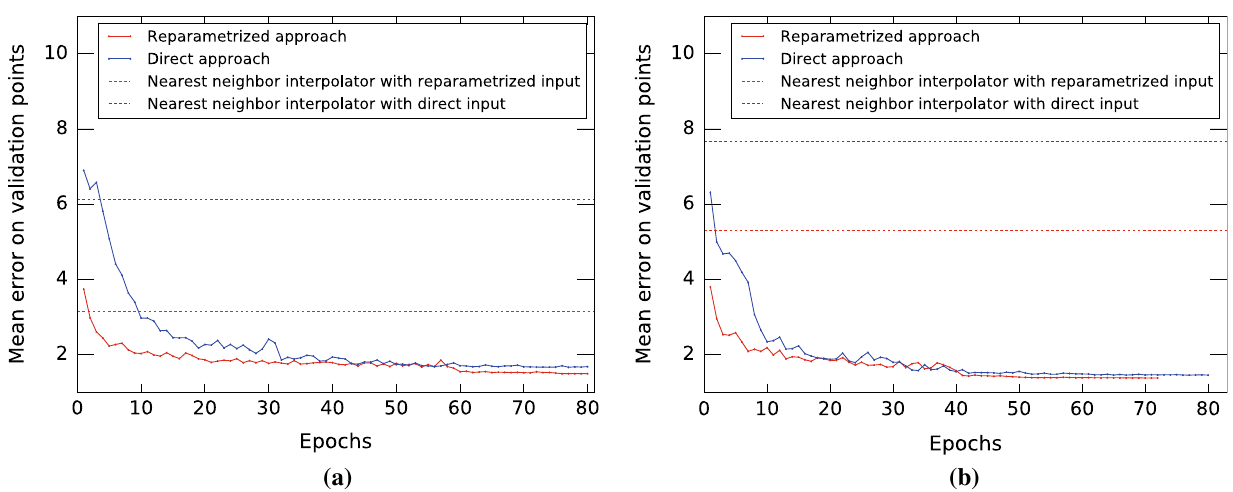
Fig. 13 Progression of the mean absolute error the direct and reparametrized neural networks achieve on the validation set after each training iteration for 8 TeV ( a ) and 13 TeV ( b )